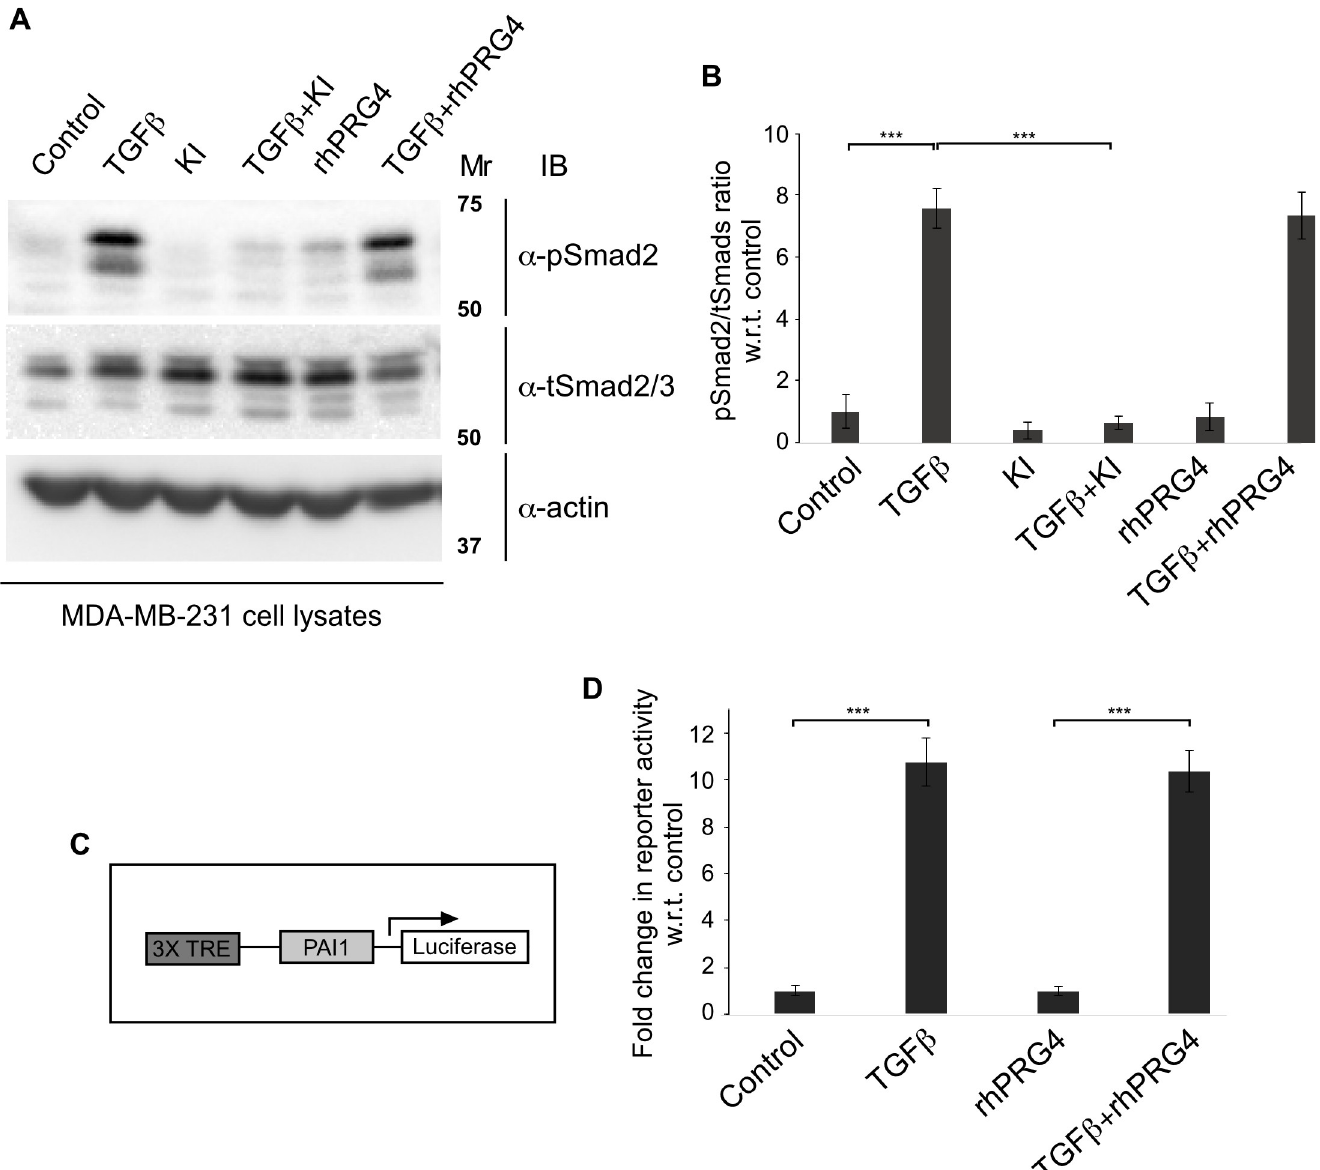
Fig 3. rhPRG4 does not affect TGF β -Smad signalling. (A) phospho-Smad2 (pSmad2), total Smad2/3 (tSmad2/3) and actin immunoblots of lysates of MDA-MB-231 cells which were either left untreated (control) or incubated with 100 pM TGF β , without or with 10 μ M KI or 100 μ g/mL rhPRG4 in complete growth medium for 12h. Mr indicates Markers’ molecular size. (B) Bar graph represents the mean ± SEM of the proportion of pSmad2 relative to the total protein abundance of total Smad2/3 and expressed as fold change with respect to the control from four independent experiments including the one shown in A. (C) A schematic representation of the 3TP-Lux reporter construct with three consecutive TPA (12-O-tetradecanoylphorbol 13-acetate) response elements (TREs) and a portion of the plasminogen activator inhibitor 1 (PAI-1) promoter region driving the expression of luciferase gene. TGF β treatment triggers the phosphorylation, nuclear translocation, and binding of the Smads to 3TP promoter leading to increase in the abundance and hence activity of the luciferase enzyme. (D ) MDA-MB-231 cells were transfected with the 3TP-Lux reporter construct along with a Renilla luciferase expression construct driven by a CMV promoter. Cells were left untreated (control) or incubated with 100 pM TGF β , without or with 100 μ g/mL rhPRG4 in 0.2% FBS-containing medium. Bar graph represents the mean ± SEM of the 3TP promoter-driven luciferase values normalized to the Renilla luciferase expression (relative light units), and the normalized data are expressed relative to the normalized luciferase data in lysates of untreated cells from three independent experiments. Significant difference, ANOVA: ��� P �